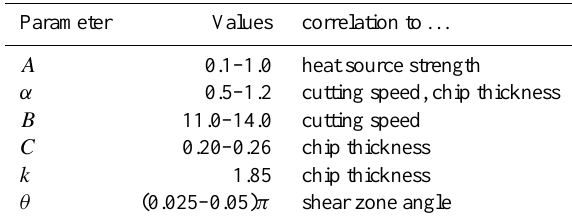
Table 1. Numerical values for F ( z